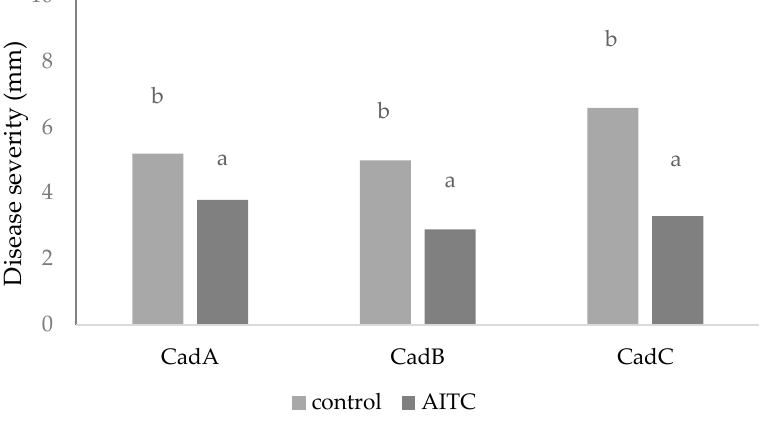
Figure 3. Effect of AITC bio fumigation on Cadophora luteo-olivacea isolates aggressiveness (mm) on kiwifruit. Biofumigated fruit were artificially inoculated with 20 µ L of CadA, CadB, CadC conidia suspensions (10 5 conidia mL − 1 ) and stored for 5 months at 0 °C. The lesion diameters (mm) were measured by removing the first layer of fruit peel. Each value is the mean of three replicates ± standard deviation. According to Tukey’s HSD Test, different letters represent significant differences within the treatment among the fungal isolates ( α = 0.05).